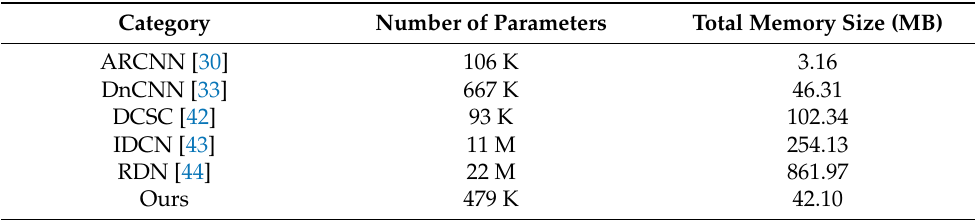
Table 9 classifies the network complexity in terms of the number of network parame- ters and total memory size (MB). The proposed DCRN reduced the number of parameters to as low as 72%, 5% and 2% of those needed in DnCNN, IDCN and RDN, respectively. In addition, the total memory size was as low as 91%, 41%, 17% and 5% of that required for DnCNN, DCSC, IDCN and RDN, respectively. Since the same network parameters were repeated 40 times in DCSC, the total memory size was large even though the number of network parameters was smaller than that of the other methods. As shown in Figure 9, the inference speed of the proposed method is greater than that of all networks, except for ARCNN. Although the proposed method is slower than ARCNN, it is clearly better than ARCNN in terms of PSNR, SSIM, and PSNR-B, as per the results in Tables 6–8. Figure 10 shows examples of the visual results of DCRN and the other methods on the test datasets. Based on the results, we were able to confirm that DCRN can recover more accurate textures than other methods. Table 9. Comparisons of the network complexity between the proposed DCRN and the previous